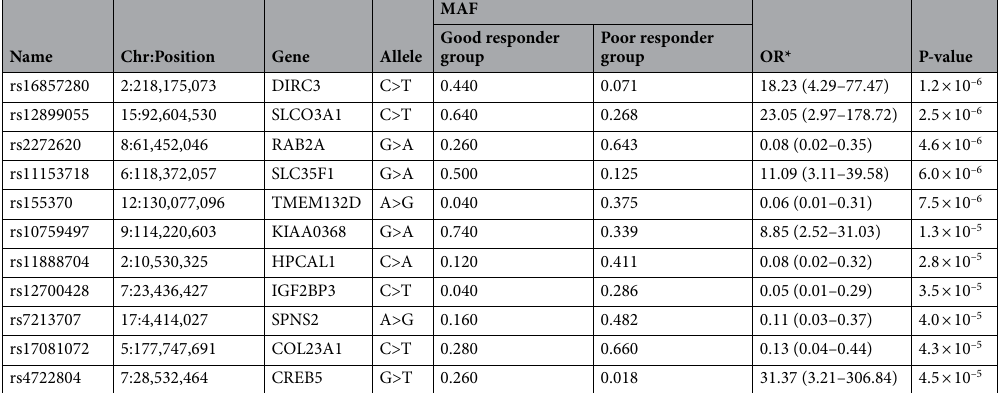
Table 2. Genotyped SNPs associated with treatment response to intravitreal anti-VEGF injection in patients with diabetic macular edema. *Odd ratios (OR) calculated with the poor responder group as a reference group and good responder group as a case group. Chr: chromosone; MAF: minor allele frequency.